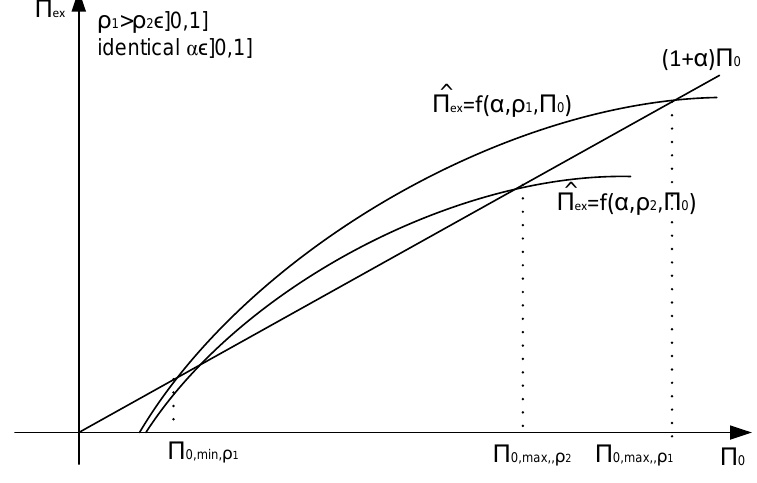
Figure 4 : Profitability zone with two different values of